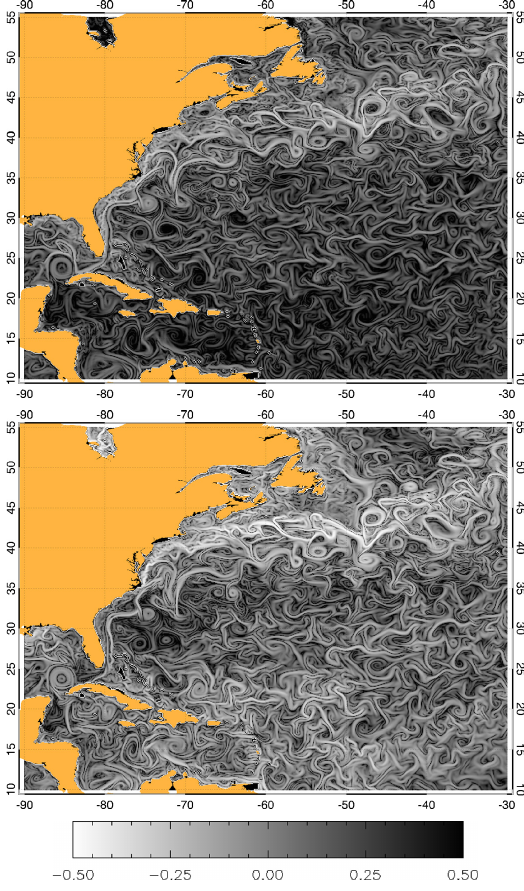
Fig. 3. Singularity exponents associated with the maps shown in Fig. 2. Top: SST, bottom: